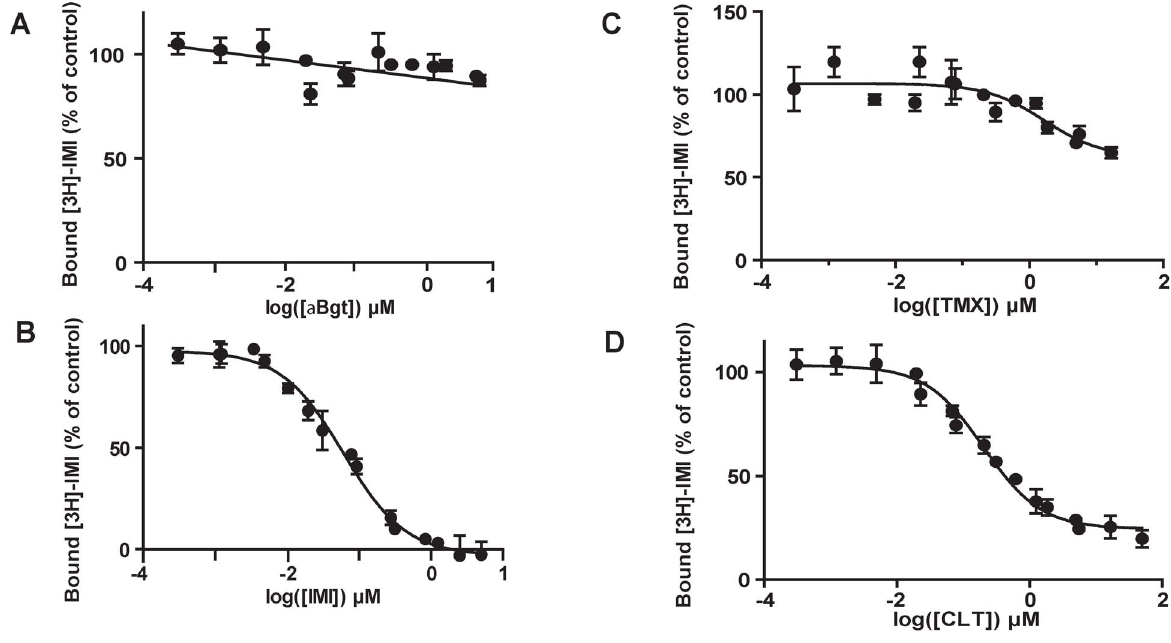
Figure 4. Neonicotinoid inhibition of [ 3 H]-imidacloprid specific binding. Inhibition curves were determined on membranes of whole parthenogenetic adults of pea aphid Acyrthosiphon pisum for (A) a -Bungarotoxin ( a -Bgt) and three neonicotinoids: (B) imidacloprid (IMI), (C) thiamethoxam (TMX) and (D) clothianidin (CLT). Results are means of four experiments. Error bars represent the SEM.